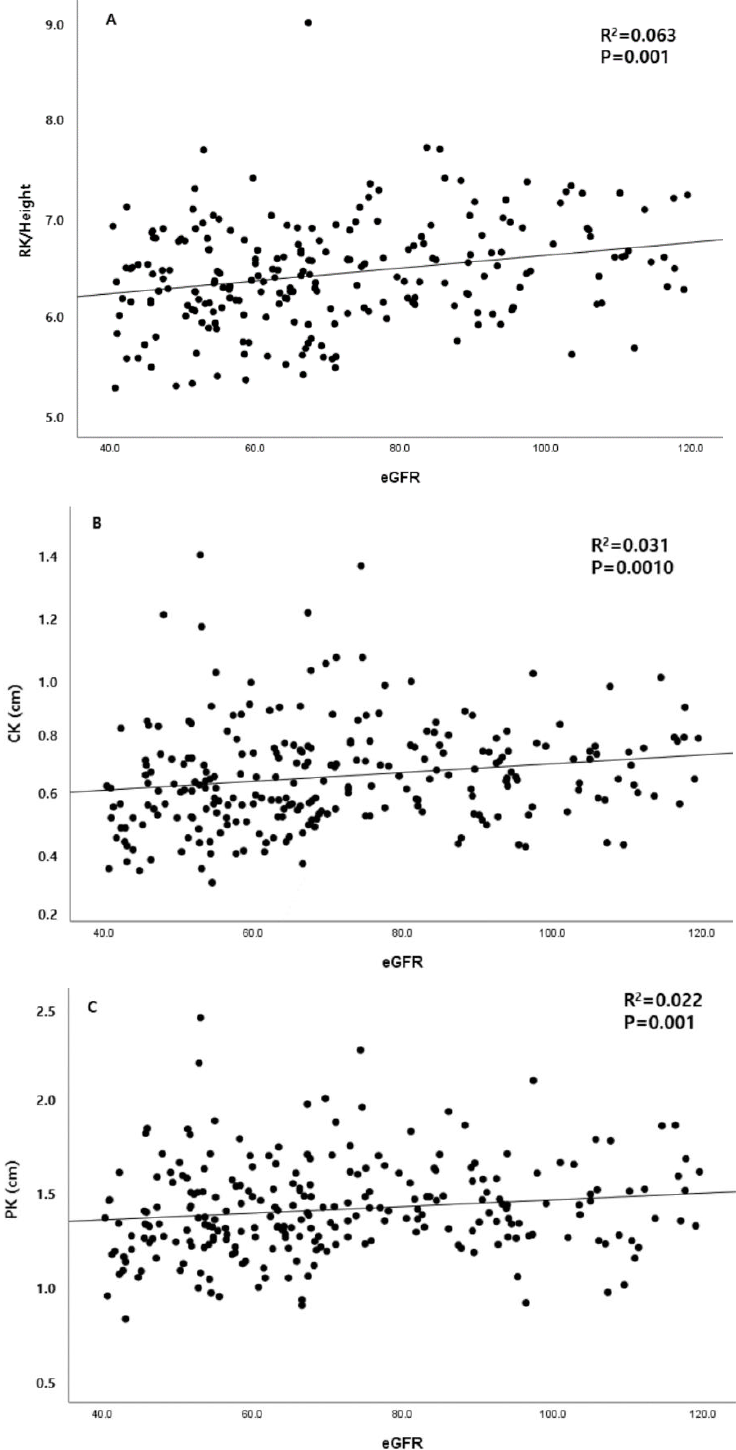
Figure 3. Correlation between ultrasound findings and baseline eGFR. ( A ) RH and eGFR. ( B ) CK and eGFR. ( C ) PK and eGFR. Abbreviations: eGFR: estimated glomerular filtration rate; RH: renal length/height; CK: cortical thickness; PK: parenchymal thickness.